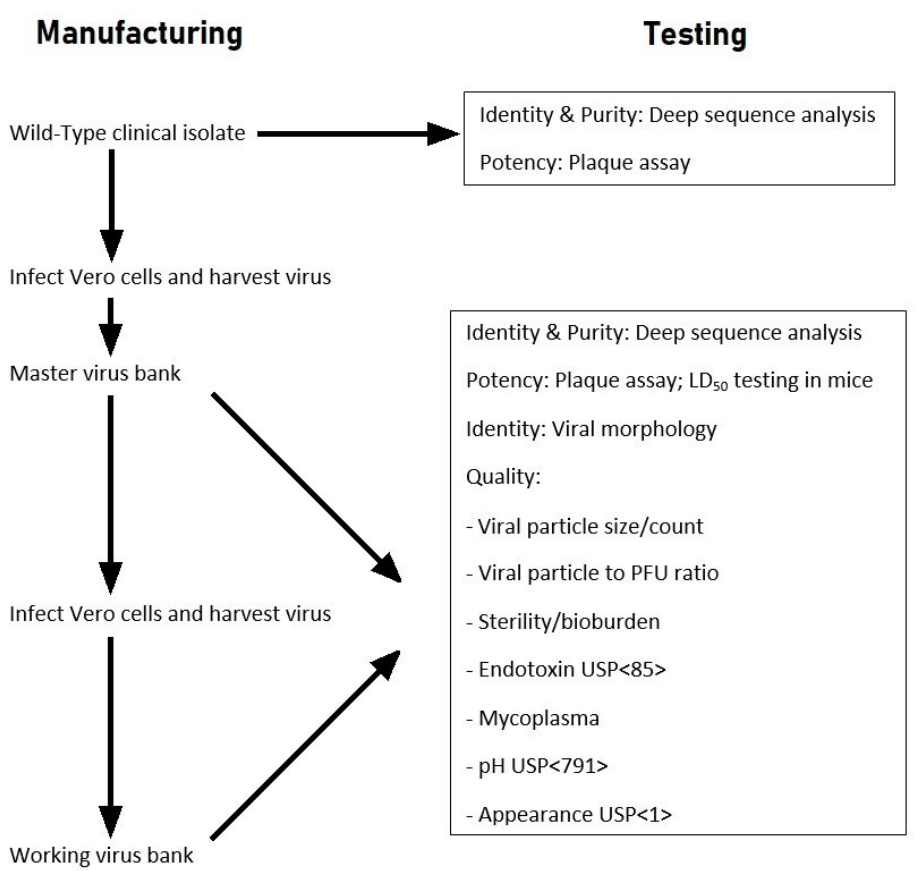
Figure 1. Process flow diagram for initial assessment and manufacturing uncloned (wild-type) VEEV TrD and INH 9813 strains for challenge material.